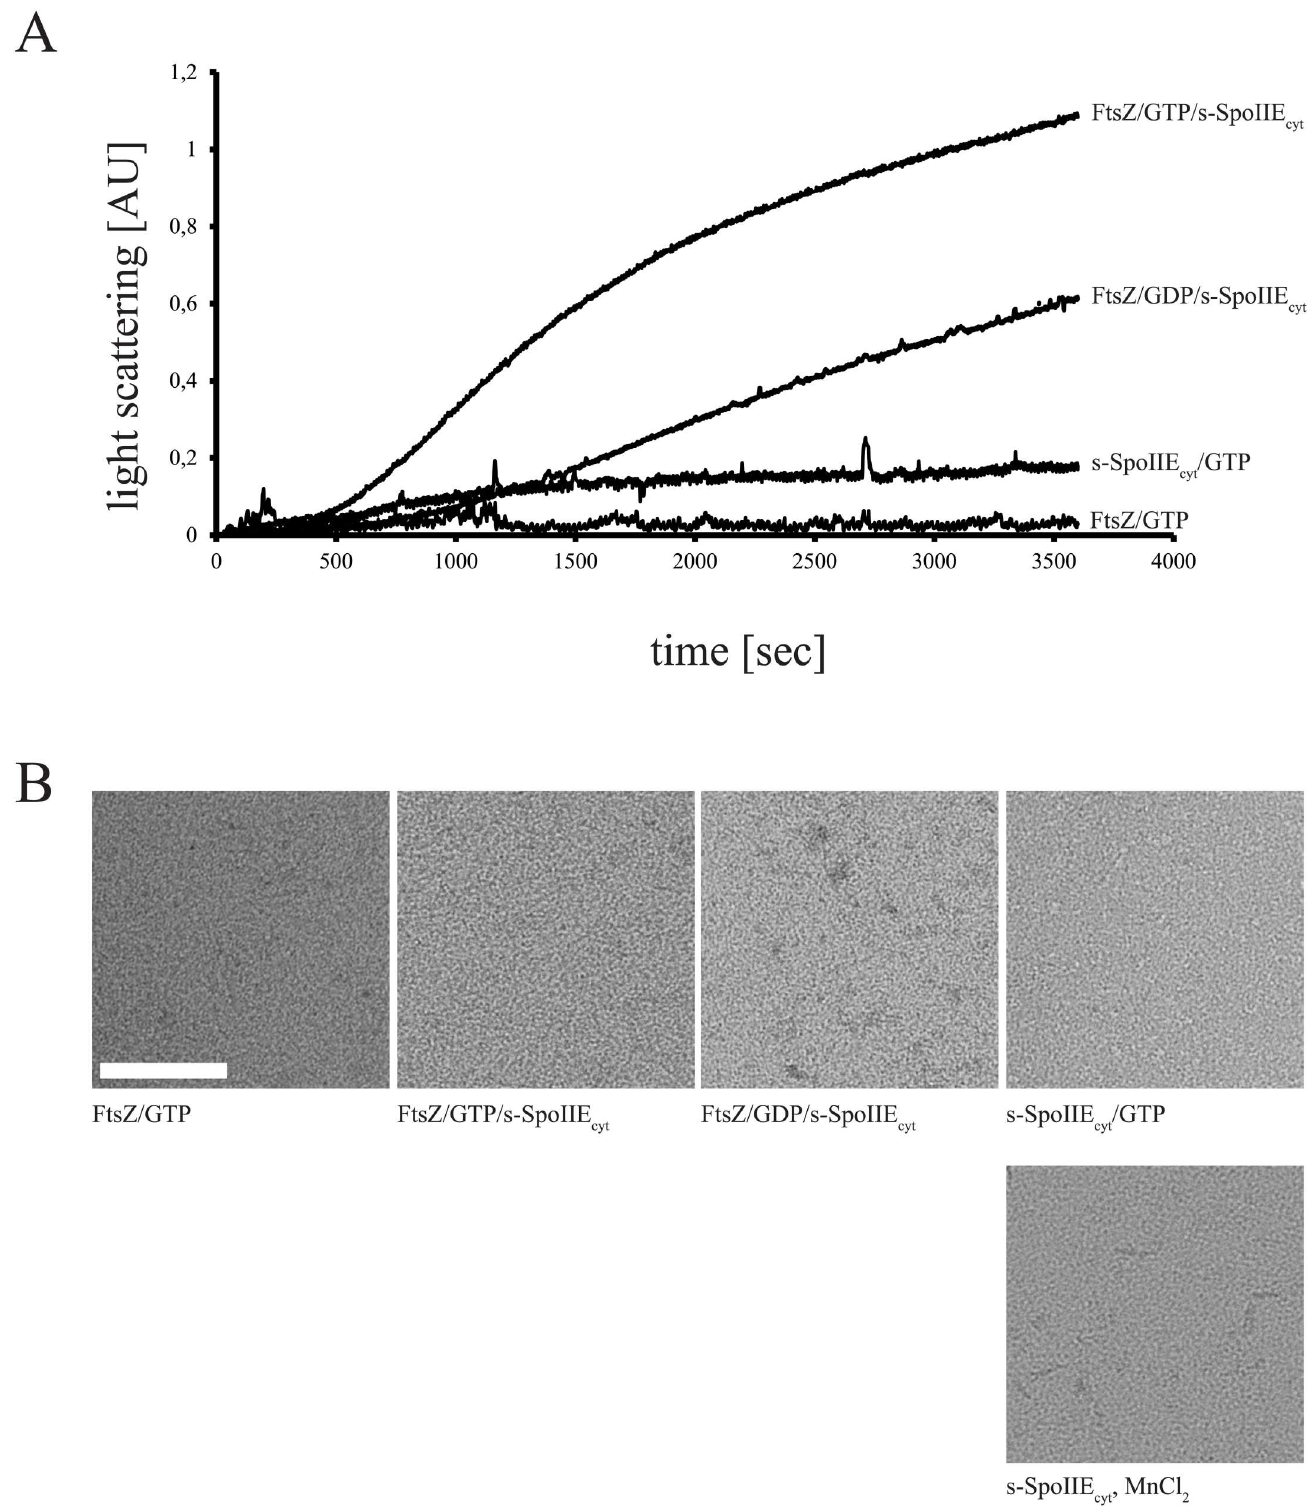
Fig 4. s-SpoIIE cyt interacts directly with FtsZ. A) Light scattering signalsof FtsZ (FtsZ/GTP) s-SpoIIE cyt (s-SpoIIEcyt/GTP) or FtsZ and s-SpoIIEcyt (FtsZ/GTP/s-SpoIIEcyt) in the presenceof GTP, or FtsZ and s-SpoIIEcyt in the presence of GDP(FtsZ/GDP/s-SpoIIEcyt). B) Electron micrographsof a similar experimentas shown in A), samples were taken after 30 min incubationand placedon EM grids. Scale bar, 100 nm.